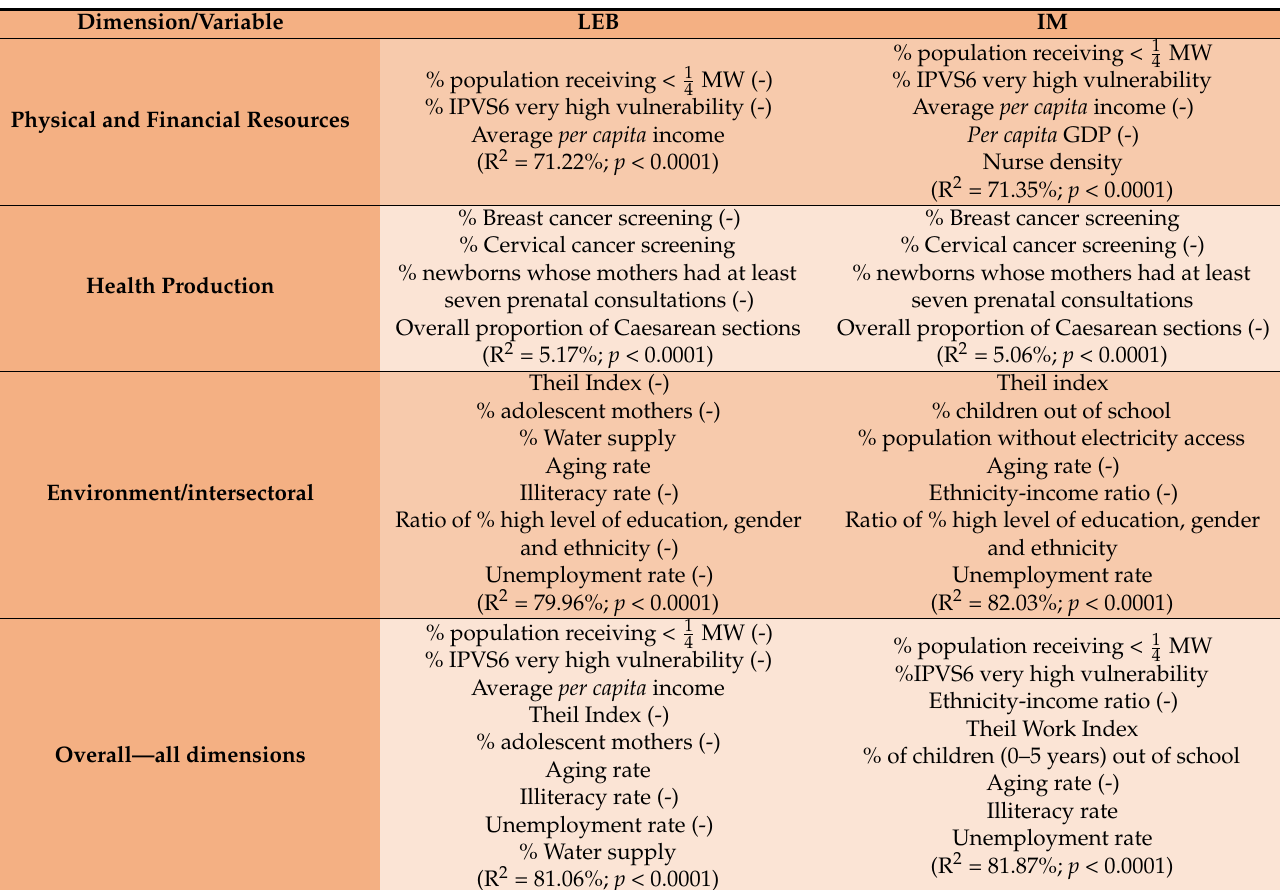
Table 2. Final FE regression models for the dependent variables, related to dimensions and to the complete set